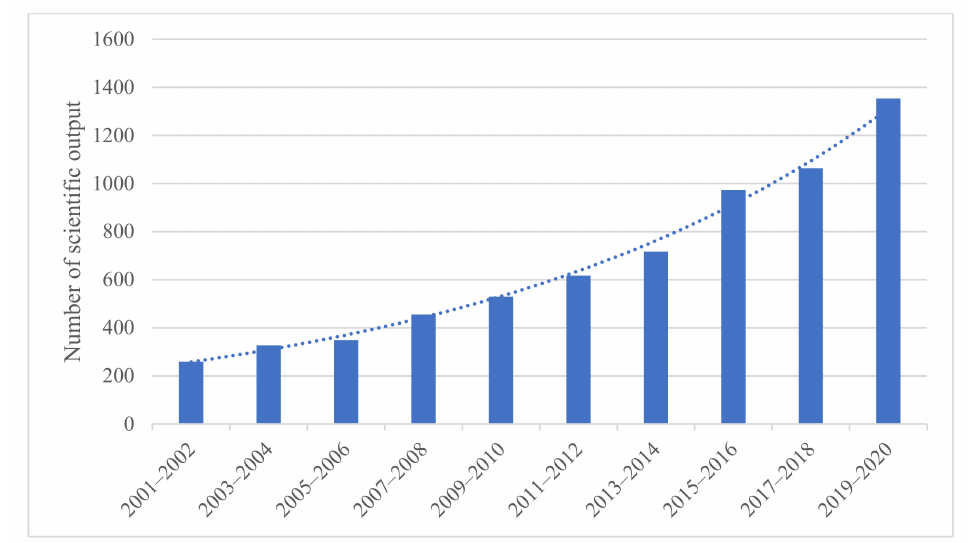
Figure 1. Trend of scientific outputs in field of soil remediation from 2001 to